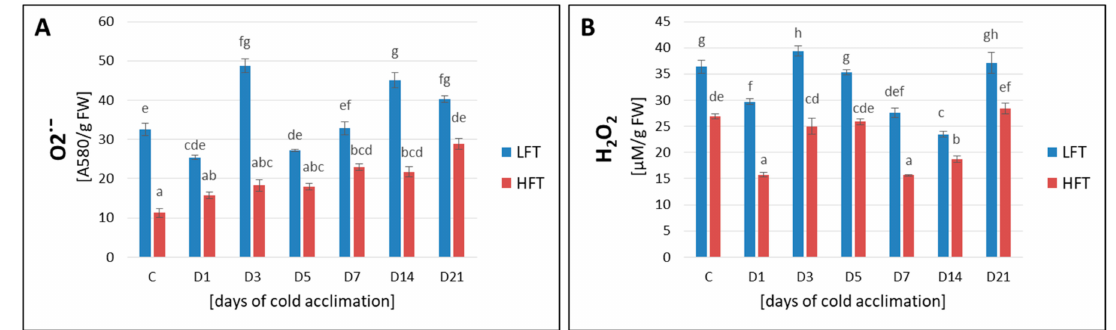
Figure 5. Superoxide anion radical (O 2 •− ) ( A ), and hydrogen peroxide (H 2 O 2 ) ( B ) content, at seven time-points: before cold acclimation (CA) C and on the 1st, 3rd, 5th, 7th, 14th, and 21st day of CA in Lolium multiflorum / Festuca arundinacea introgression forms. Error bars represent the standard errors of five replicates. Homogeneity groups are denoted by the same letters, according to Fisher’s LSD test ( p = 0.05). HFT–high freezing tolerant introgression form, LFT–low freezing tolerant introgression form; FW–fresh